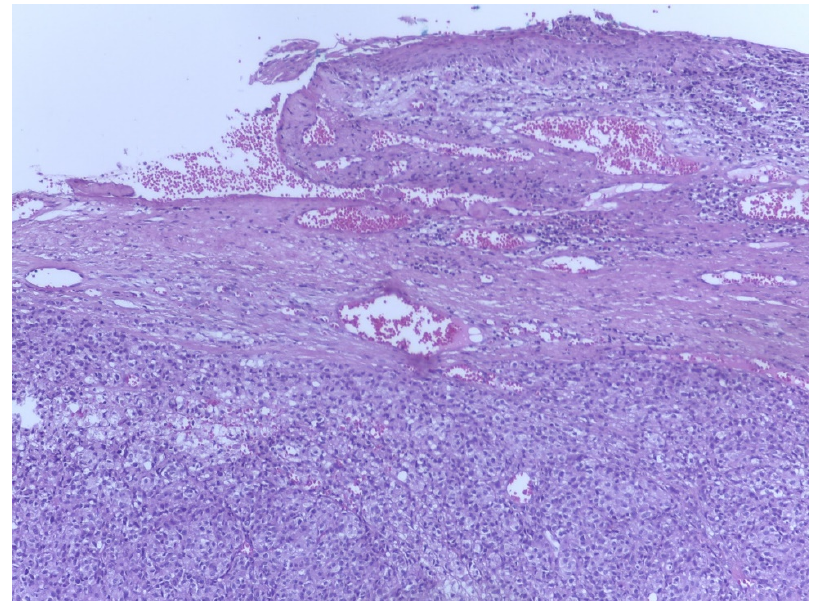
Figure 3. Vaginal melanoma. Vaginal squamous epithelium with areas of ulceration. In lamina pro- pria one can observe tumoral cells organized in nests. Hematoxylin-eosin stain, original magnification ×4 (histological image courtesy of dr. Ileana Popa).